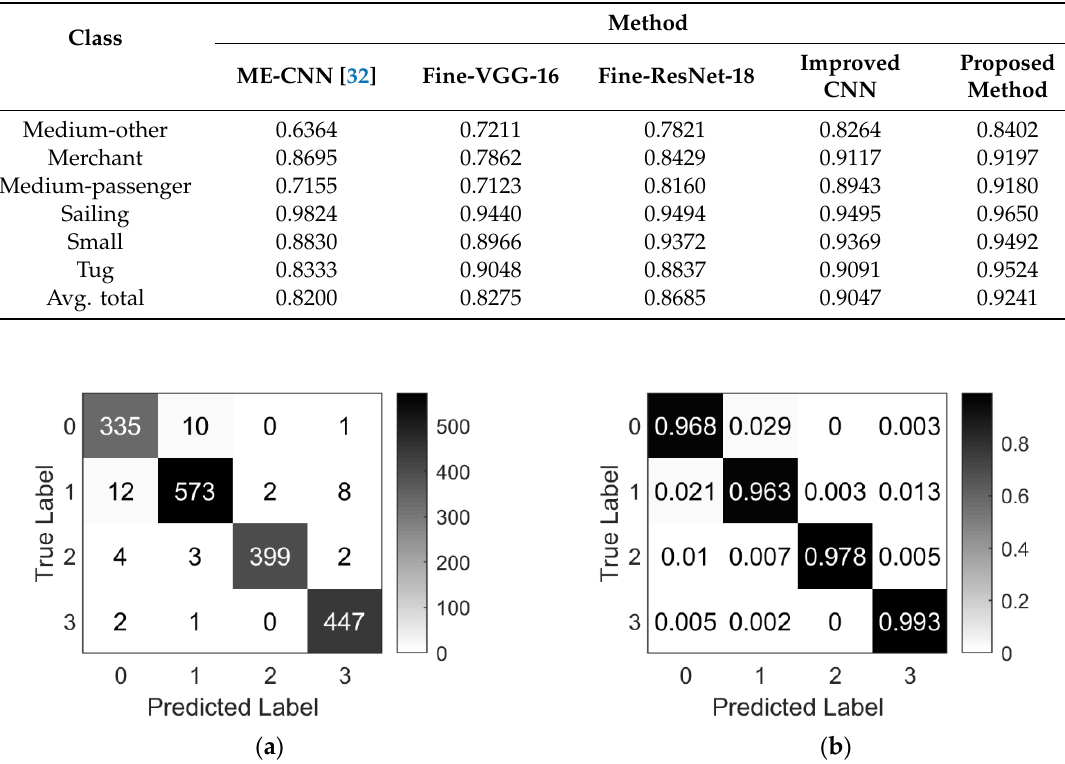
Table 12. F1-score obtained using di ff erent CNN methods when applied to the VAIS dataset.